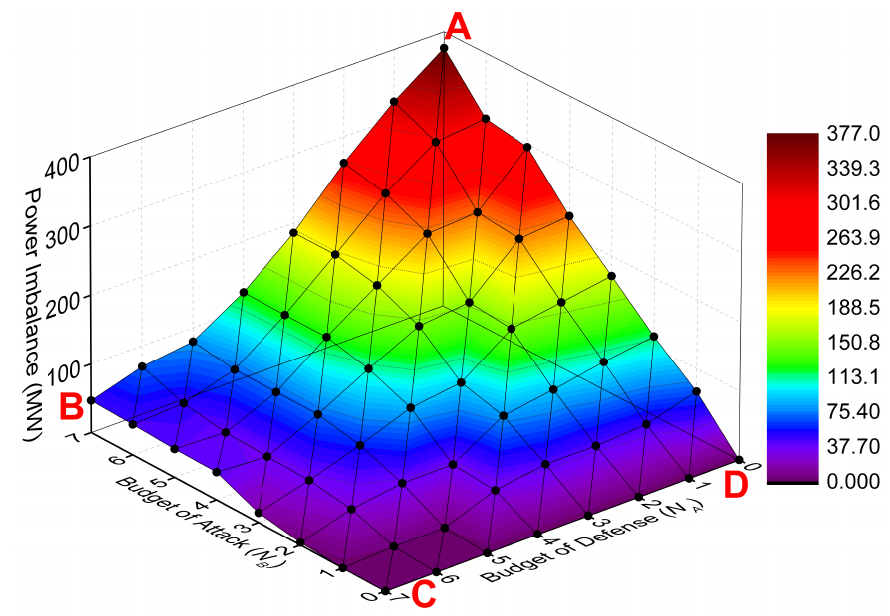
Figure 8. Power imbalance with the deception strategy under different defense and attack budgets.